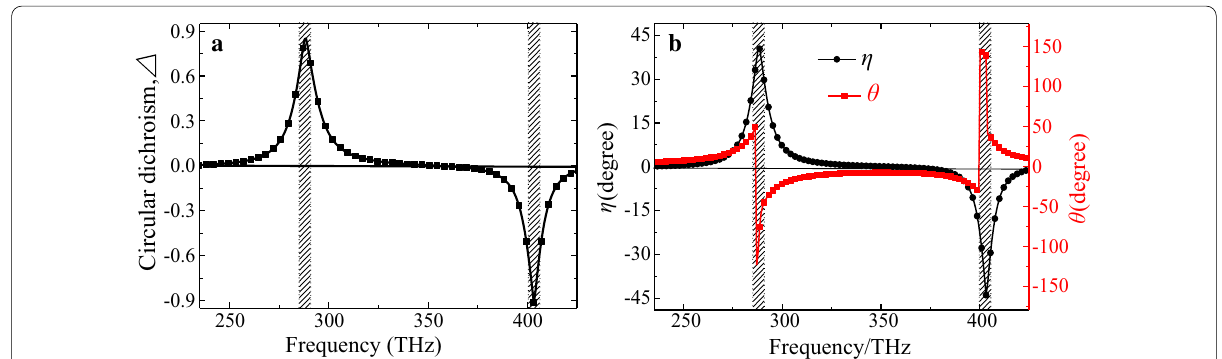
Fig. 3 The calculated relative optical parameters of the proposed CMSA for the normal incident LCP and RCP lights, a the CD parameter Δ , b ellipticity angle η and polarization azimuth rotation angle